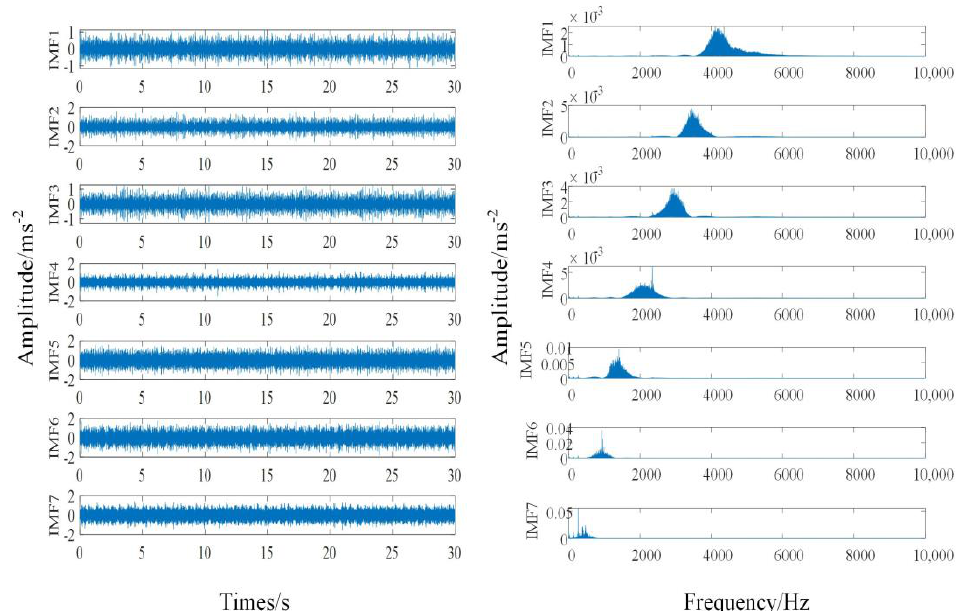
Figure 11. Time–frequency diagram of VMD: ( a ) time domain plots for each IMF component; Figure 11. Time – frequency diagram of VMD: ( a ) time domain plots for each IMF component; ( b ) ( b ) frequency domain plots for each IMF component. frequency domain plots for each IMF component.